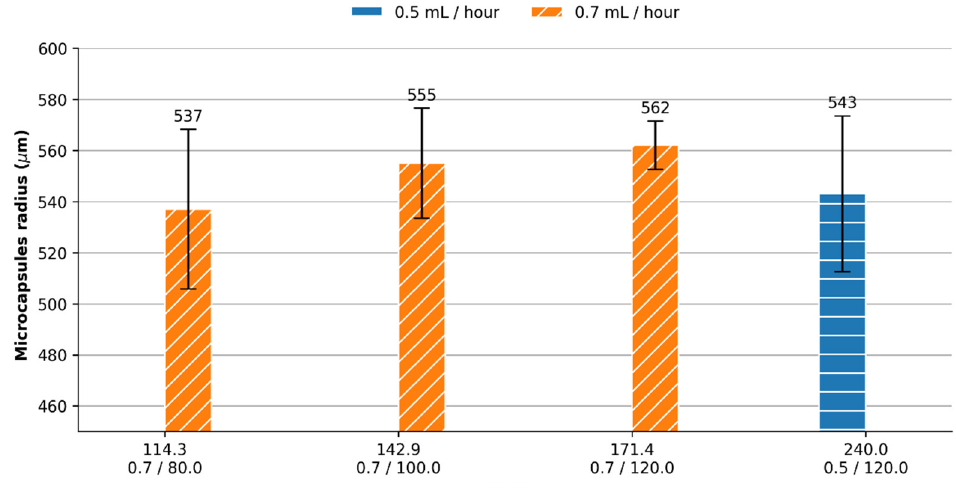
Figure 3. Mean radius of microcapsules upon Q c /Q d ratio. Error bars correspond to the standard deviation.